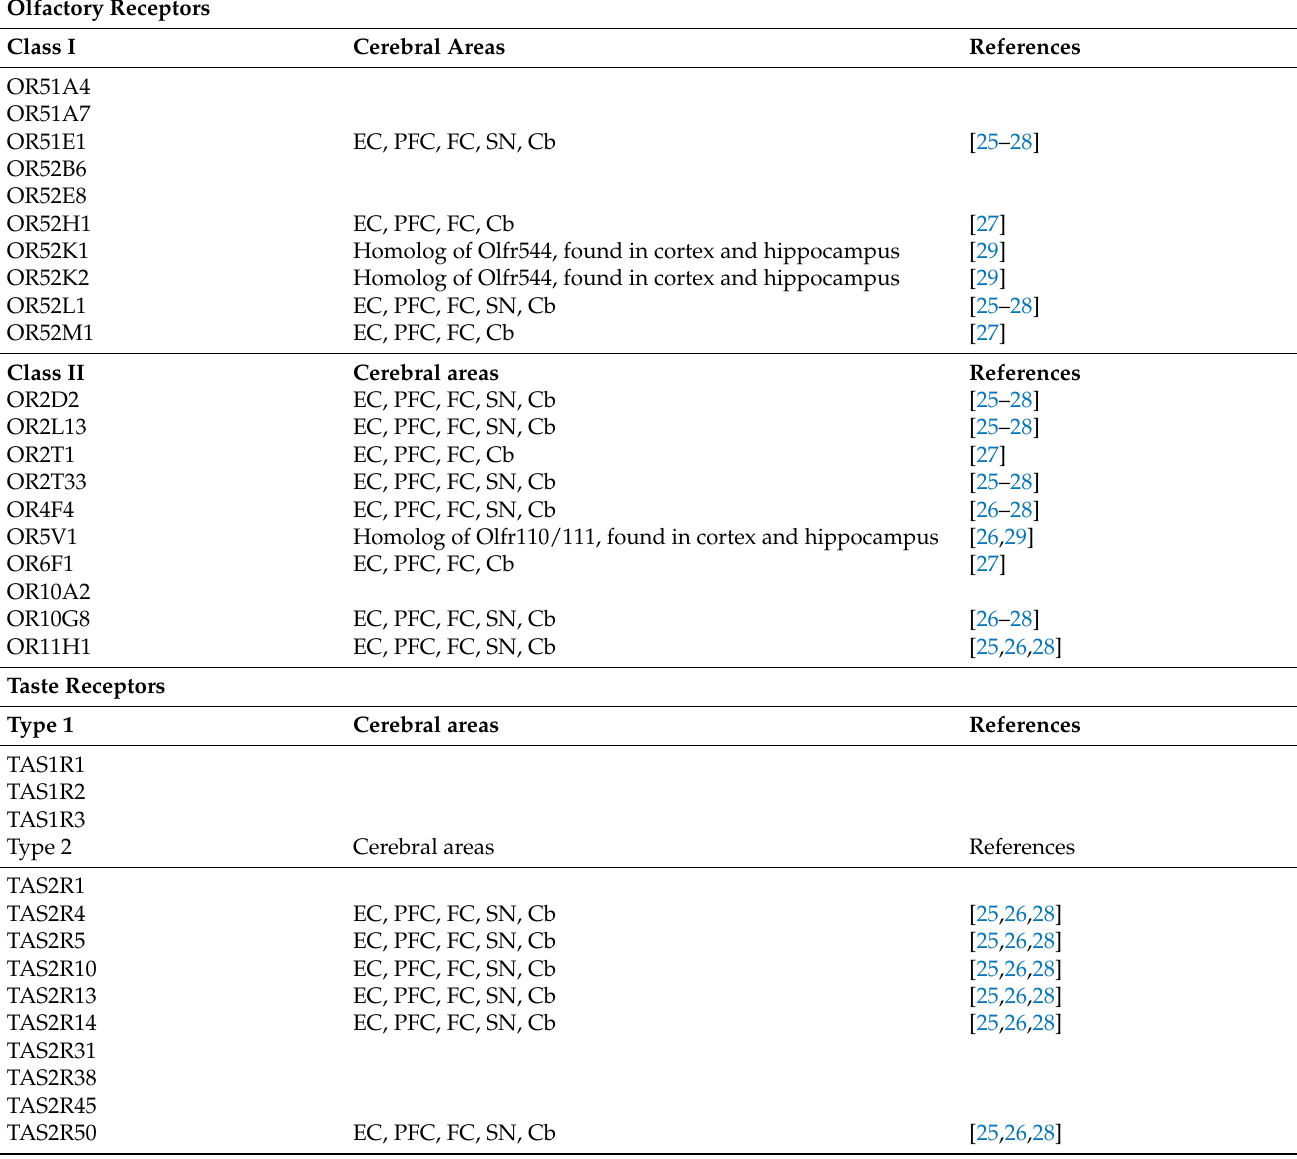
Table 3. Selected olfactory receptors (OR) and taste receptors